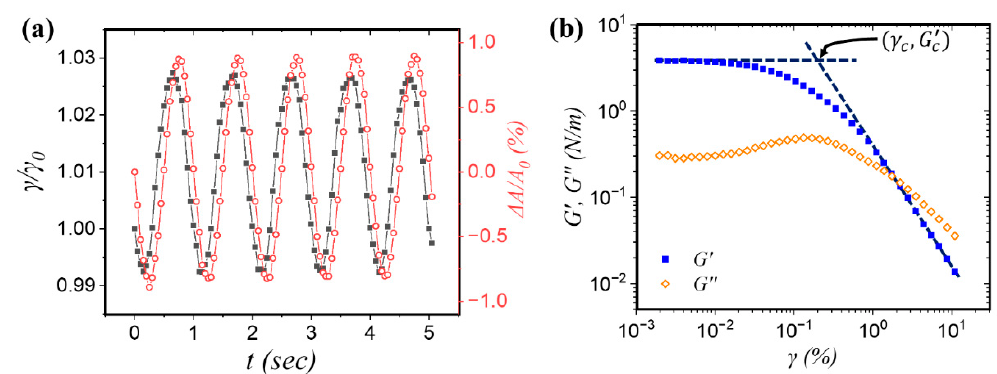
Figure 4. (Color online) Examples of data acquired from interfacial rheology measurements: ( a ) a bubble suspended in a 2 mM sodium dodecyl sulfate (SDS) surfactant solution and oscillated at 1 Hz. Data depicts the change in surface tension ( γ ), normalized by the initial surface tension value ( γ 0 ), (solid black symbol) vs. time due to the applied strain (open red symbol)—variations in the surface area ( ∆ A ) normalized by the initial area ( A 0 ). The phase shift ( δ ) between the two curves is used to calculate the contributions to the complex modulus ( E ) as defined in Equation (5); ( b ) data on oscillatory shear rheology measurement performed using a TA Instruments Discovery Hybrid Rheometer-2 (DHR-2) via the DWR geometry (inner cup diameter: 62 mm, inner ring diameter: 69 mm, outer ring diameter: 71 mm, outer cup diameter: 79 mm, ring thickness: 1 mm). Measurements were carried out at 1 Hz on the air/water interface decorated with silica/gold Janus particles. For this dataset, 5 mg of Janus particles were suspended in 200 µ L of 70/30 wt% isopropyl alcohol/water mixture that was used as a spreading solvent. After deposition, the interface was left undisturbed for 20 min to allow for the IPA evaporation. The silica/gold Janus particles were fabricated from 1 µ m spherical silica particles (Fiber Optic Center, Inc.) half-coated with a 5 nm-thick adhesive layer of titanium followed by a 10 nm gold deposition. The gold face is then modified with dodecanethiol molecules to boost the amphiphilicity of the Janus particle ( ∆ θ ∼ 40 ◦ ). The solid symbol illustrates the elastic ( G (cid:48) ) contribution and the open symbol shows the viscous ( G (cid:48)(cid:48) ) contribution vs. strain ( γ ) in a log-log plot. The critical strain ( γ c ) and the low-strain plateau elastic modulus ( G (cid:48) c ) were obtained using a procedure detailed in Ref. [98] and the yield stress ( τ y ) value, calculated using Equation (6), was ∼ 0.007 Pa.m for this sample